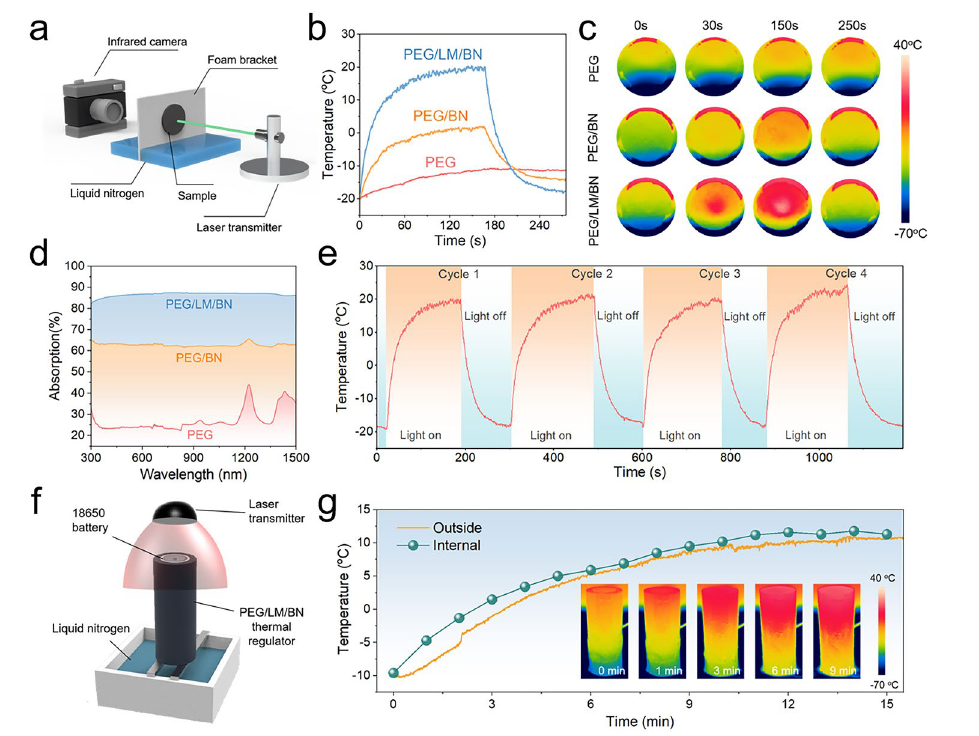
Fig. 4 a Schematic of the test system used to investigate light-to-heat conversion capability including a laser light generating the powerful irra- diation, an infrared (IR) camera recording the surface temperature of the sample and some liquid nitrogen placed in the foam chamber creating a low-temperature environment. b Average surface temperature of pure PEG, PEG/BN composite (loading content of 30 vol%) and PEG/LM/ BN composite (loading content of 30 vol%) versus time of the test including light on (first half) and light off (the latter half). Note that the power of the laser light is 4 W. c Visualized light-to-heat conversion of pure PEG, PEG/BN composite (loading content of 30 vol%) and PEG/LM/ BN composite (loading content of 30 vol%) recorded by IR camera. d UV–vis–NIR light absorption spectra of pure PEG, PEG/BN composite (loading content of 30 vol%) and PEG/LM/BN composite (loading content of 30 vol%). e Average surface temperature profiles of the PEG/LM/ BN composite (loading content of 30 vol%) undergoing light on and light off after 4 cycles, showing the stability of heat generation at low tem- perature. f Schematic of heating the battery by utilizing the photothermal conversion ability of PEG/LM/BN thermal regulator. g Temperature profiles of the PEG/LM/BN thermal regulator upon the irradiation of the laser